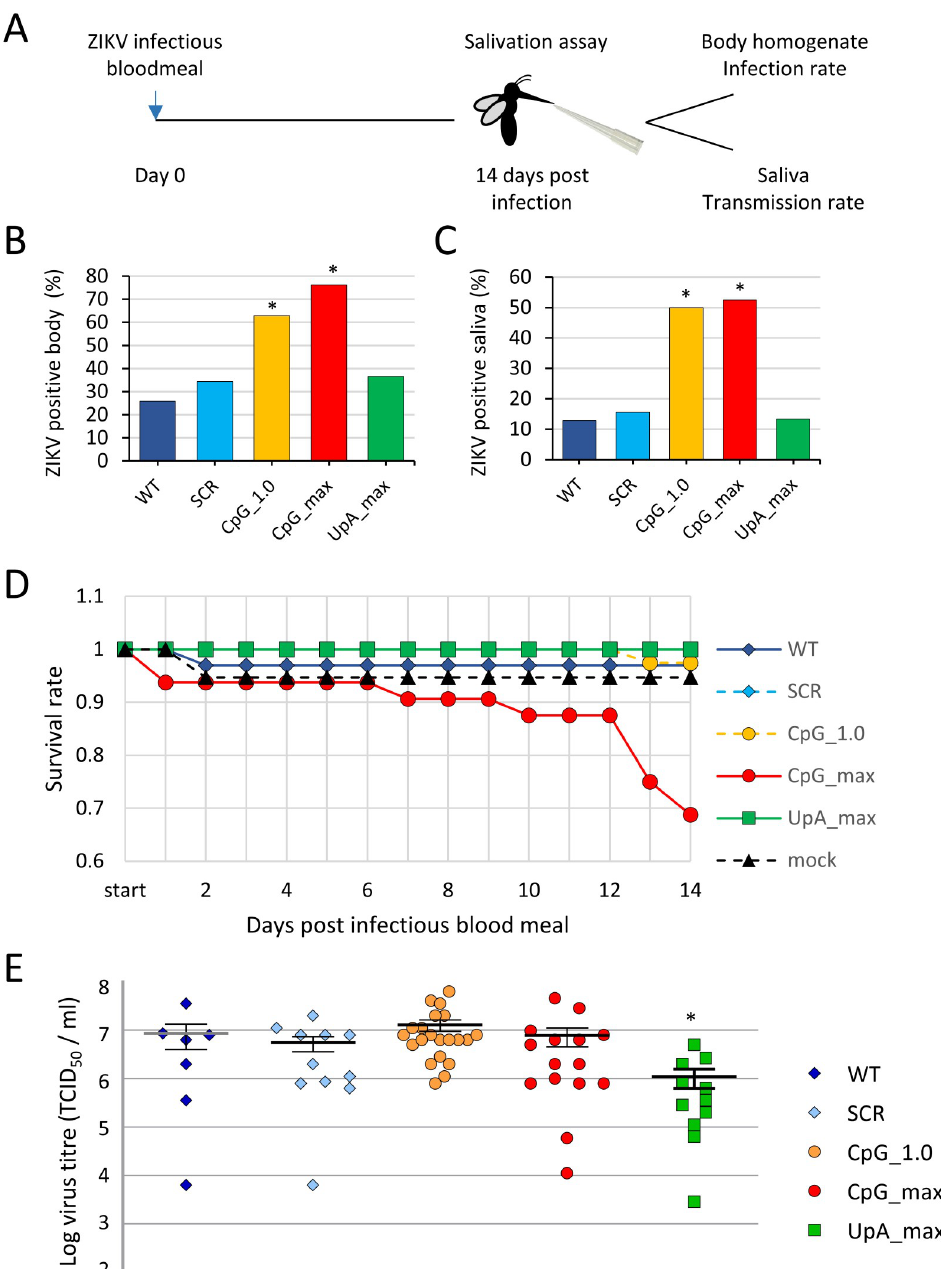
Fig 5. Infection of Aedes aegypti with ZIKV mutants. Aedes mosquitoes were offered an infectious blood meal containing equal RNA concentrations of each of the ZIKV. Fully engorged females were selected and 14 days later subjected to a salivation assay (A) . Mosquito body homogenates (B) and mosquito saliva (C) were inoculated on Vero E6 cells to detect the presence of infectious virus. Bars represent the percentage of ZIKV-positive samples with n between 21 and 36 engorged mosquitoes per experimental group. Asterisks represent significant difference from WT (Fisher exact test, p < 0.01). Survival rate of blood-fed mosquitoes during the experiment was differentially affected by mutant viruses (log-rank test, p < 0.001), with n between 31 and 39 mosquitoes that had engorged an infections blood meal at the start of the experiment (D). The infectious virus titer inside ZIKV-positive mosquito bodies was determined by end-point dilution assays. Data points indicate individual mosquito samples and the mean and SEM for each experimental group are displayed. Asterisk indicates significant difference from WT (Mann–Whitney U , p < 0.05) (E). Please refer to S1 Data for the numerical values underlying panels B–E. SCR, scrambled control virus; WT, wild-type; ZIKV, Zika virus.